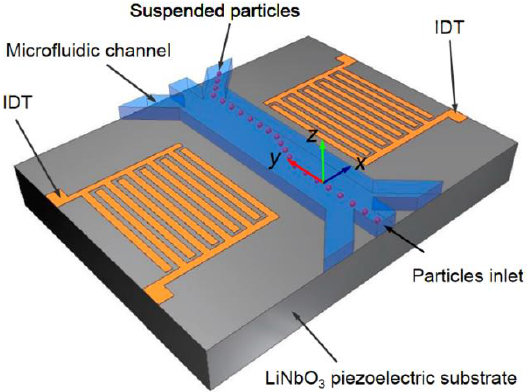
Figure 23. A generic approach for SAW devices with microfluidics [185].